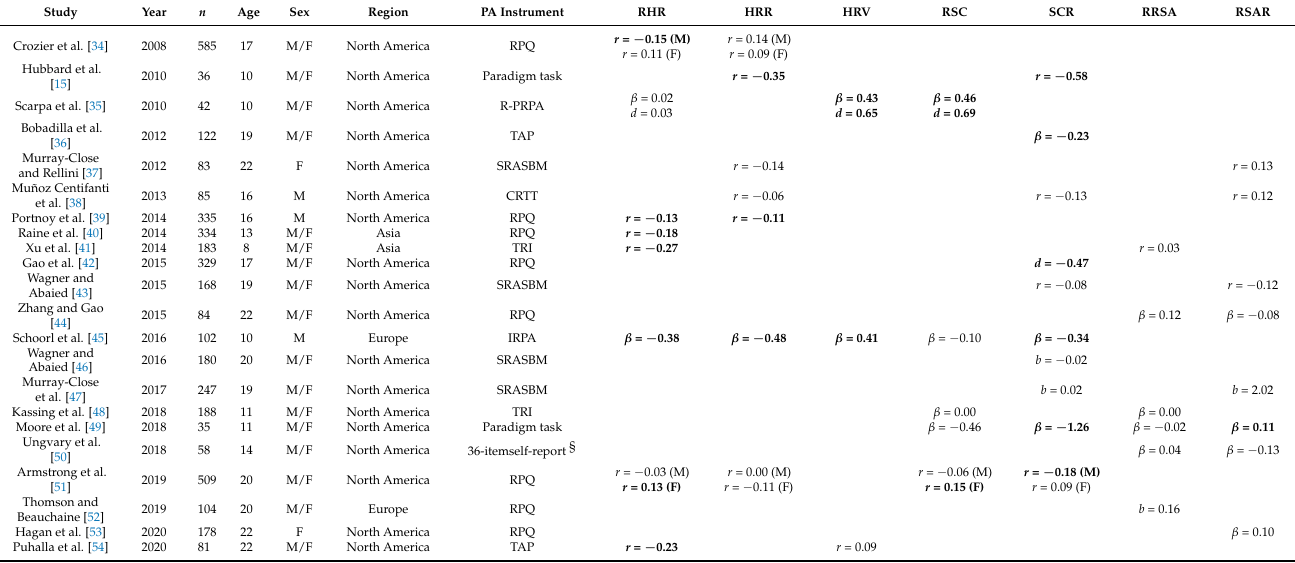
Table 1. Physiological findings according to resting heart rate (RHR), heart rate reactivity (HRR), heart rate variability (HRV), resting skin conductance (RSC), skin conductance reactivity (SCR), resting respiratory sinus arrhythmia (RRSA), and respiratory sinus arrhythmia reactivity (RSAR) of included studies.